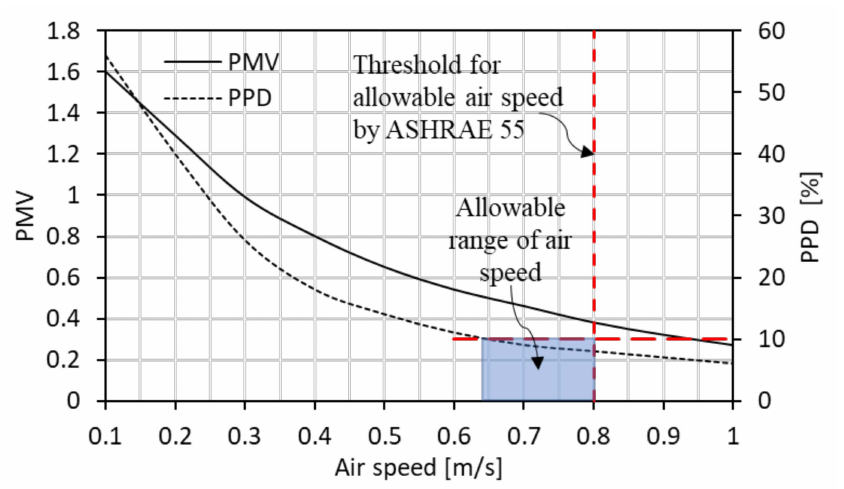
Figure 5. Effect of air speed on PMV and PPD